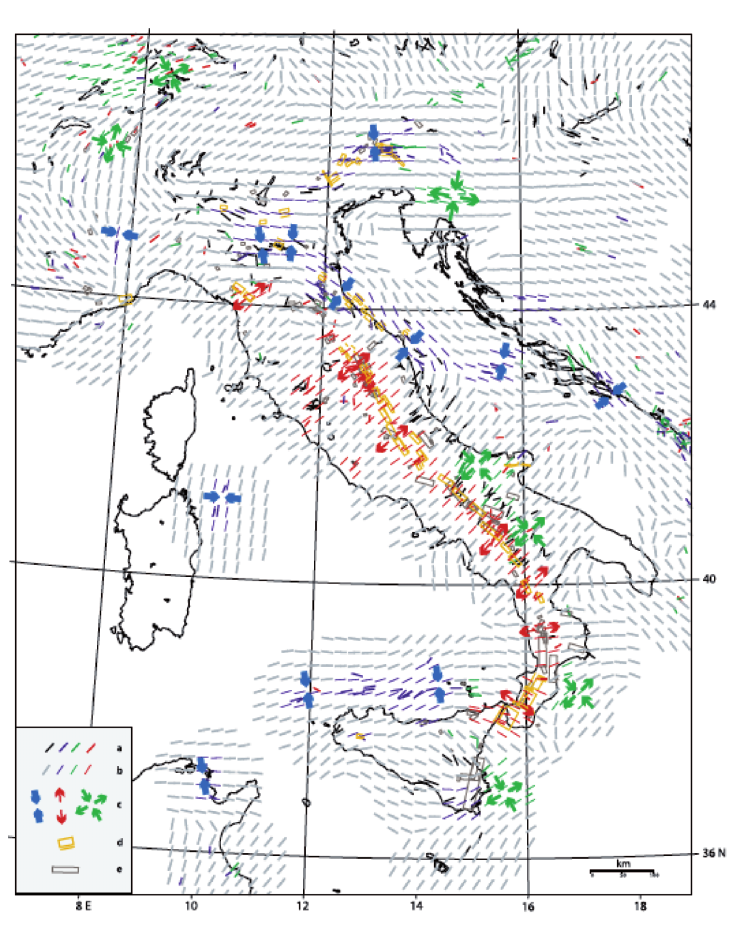
Fig. 7. Smoothed Sh min orientation and stress regime of the Italy region. a) Sh min directions from our dataset and the World Stress Map 2003 release (colours show different tectonic regimes: black is unknown, blue is com- pressional, green is strike-slip, and red is extensional); b) smoothed stress directions (colours as before); c) di- rections of inferred regional stress regimes (colours as before); and d) and e) integrated seismogenic sources from geological/ geophysical (yellow) and well constrained historical (grey) data (after Montone et al. ,